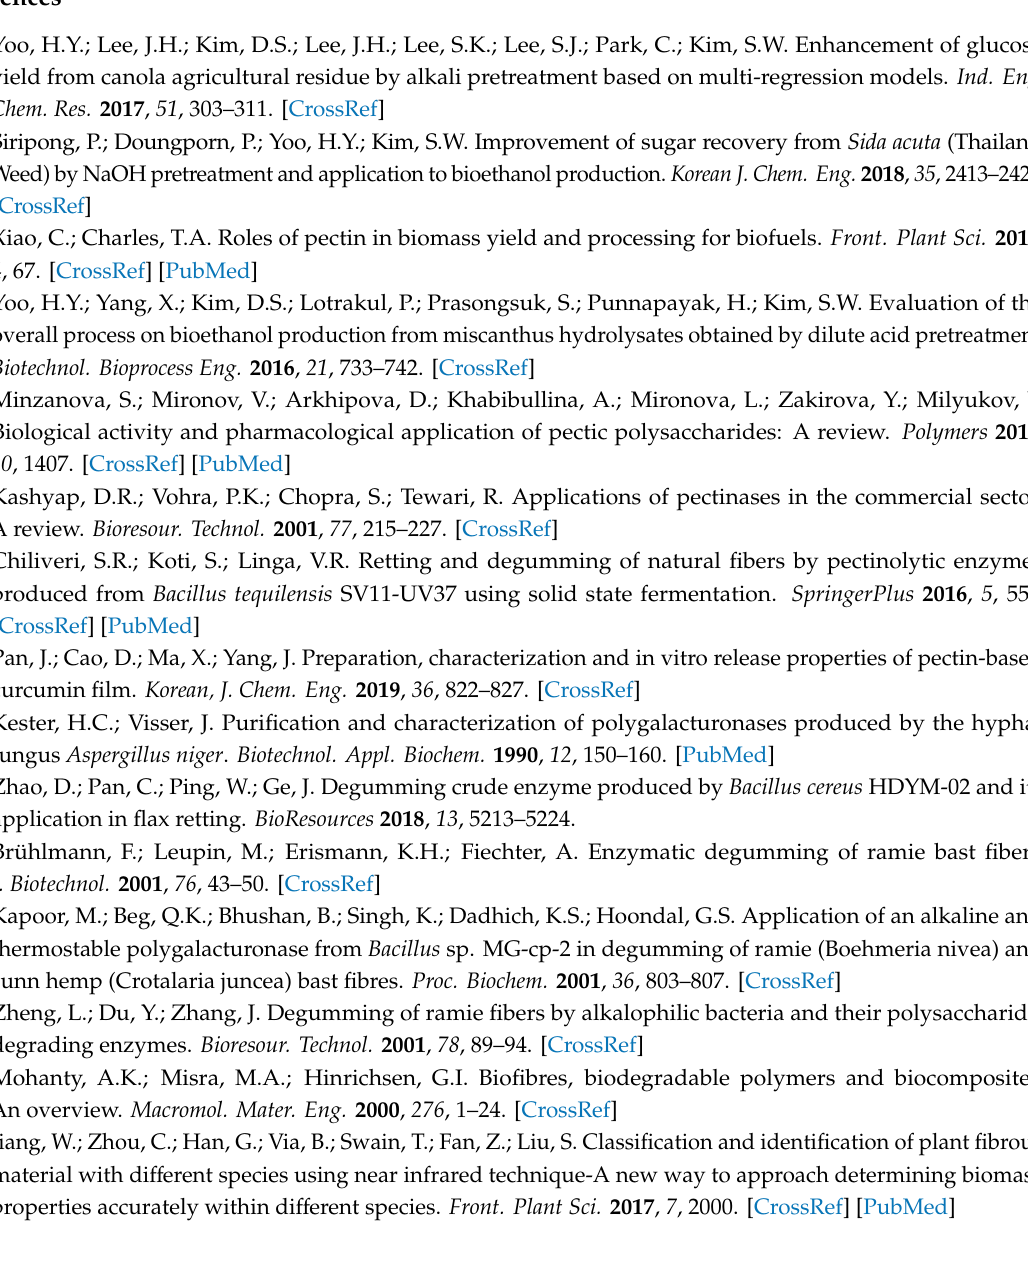
Figure S1: Lineweaver–Burk Plot, Figure S2: Hanes–Woolf Plot, Figure S3: Eadie–Hofstee